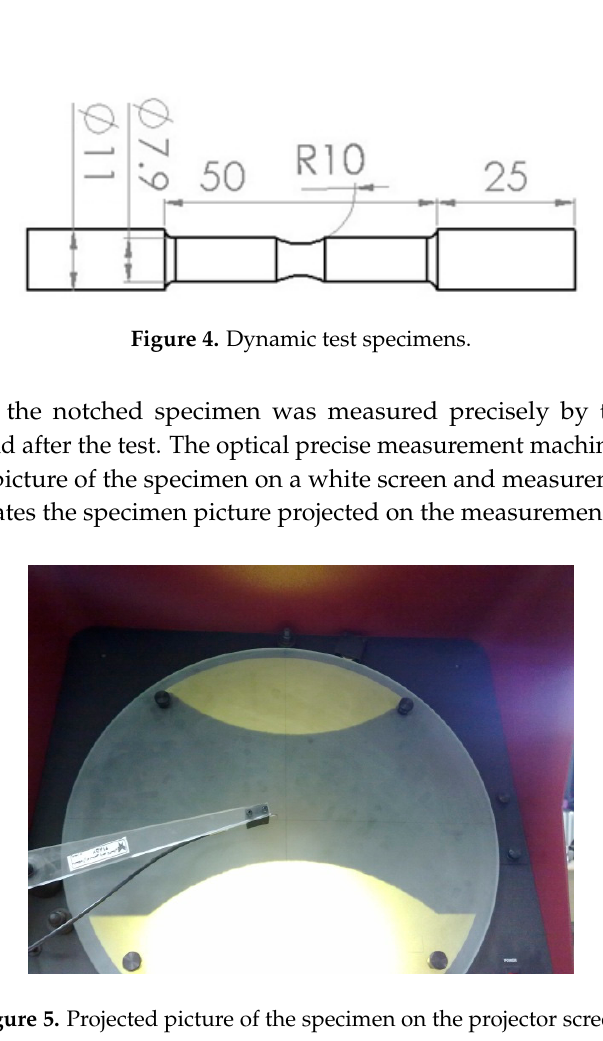
Figure 3. Flying Wage testing apparatus